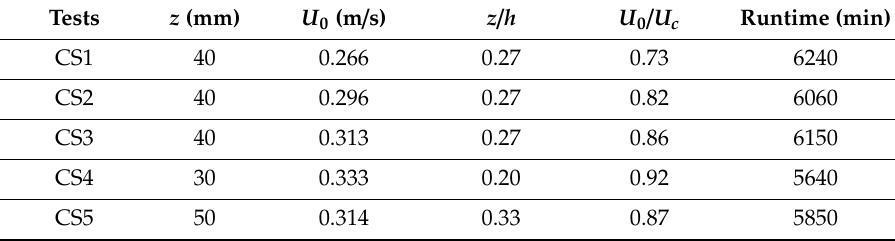
Table 1. Summary of experimental conditions.